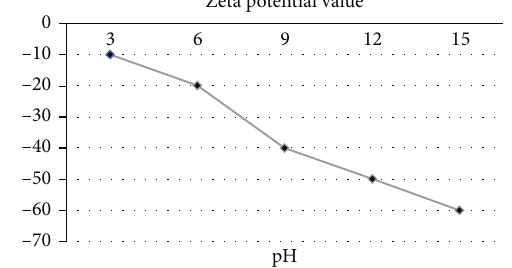
Figure 2: Surface area graph of GO and NGPPC adsorbents.